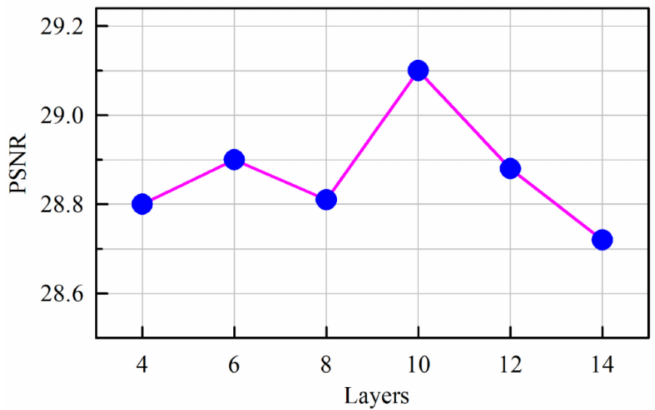
Figure 7. Average PSNR values on 10 images for different depths of